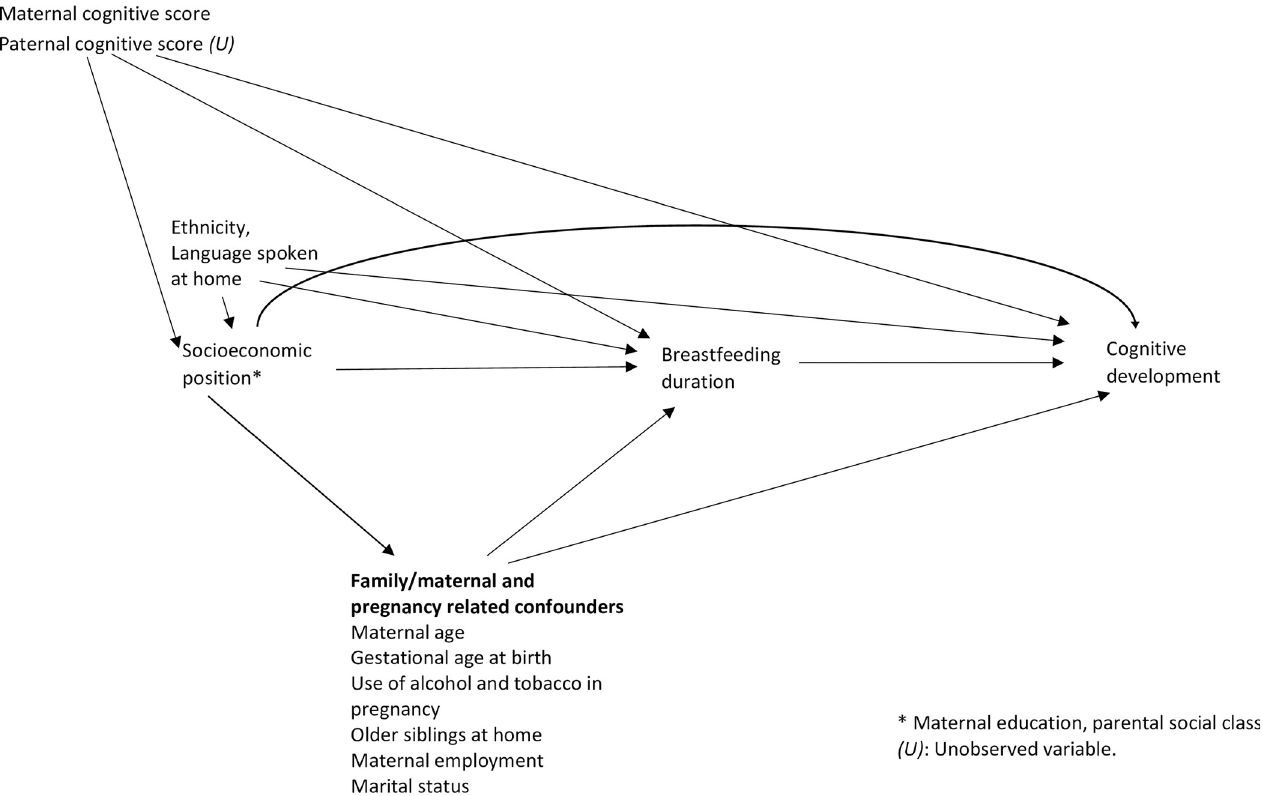
Fig 2. Directed acyclic graph used for the evaluation of the association between breastfeeding duration and cognitive development.